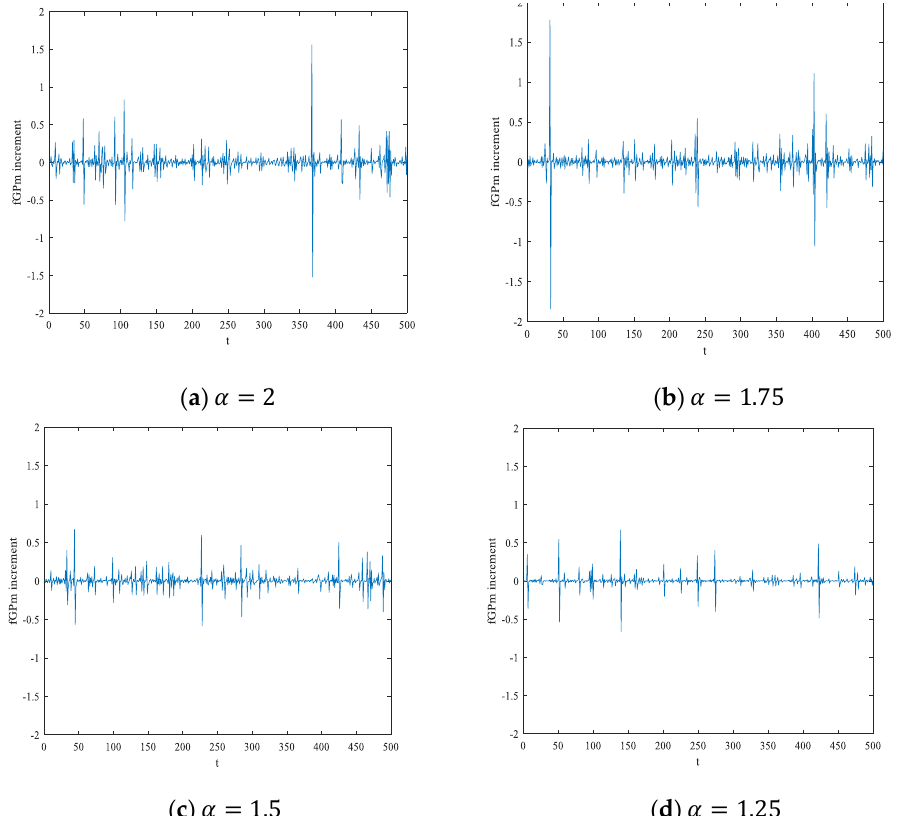
( d ) 𝛼 = 1.25 Figure 8. fGPm generated with different 𝛼 = 2, 1.75 , 1.5 ,1.25 , respectively, 𝐻 = 0.75 . 3.2. Fractional Generalized Pareto Motion Incremental Processes Model The 1-step incremental model of fGPm is obtained from the identity 𝑋 𝐻,𝛼 (𝑡) = 𝑃 𝐻,𝛼 (𝑡 + 1) − 𝑃 𝐻,𝛼 (𝑡) : 𝑋 𝐻,𝛼 (𝑡) = 𝑃 𝐻,𝛼 (𝑡 + 1) − 𝑃 𝐻,𝛼 (𝑡) = ∫ {𝑎[(𝑡 + 1 − 𝑠) +𝐻−1/𝛼 − (−𝑠) +𝐻−1/𝛼 ] ∞ −∞ + 𝑏[(𝑡 + 1 − 𝑠) −𝐻−1/𝛼 − (−𝑠) −𝐻−1/𝛼 ]}𝜔 𝛼 (𝑠)𝑑𝑠 (15) where 𝜔 𝛼 (𝑠) = 𝑝[𝑑(𝑠 + 1)] − 𝑝(𝑑𝑠)] . From Section 2.1, we can see that 𝜔 𝛼 (𝑠) follows